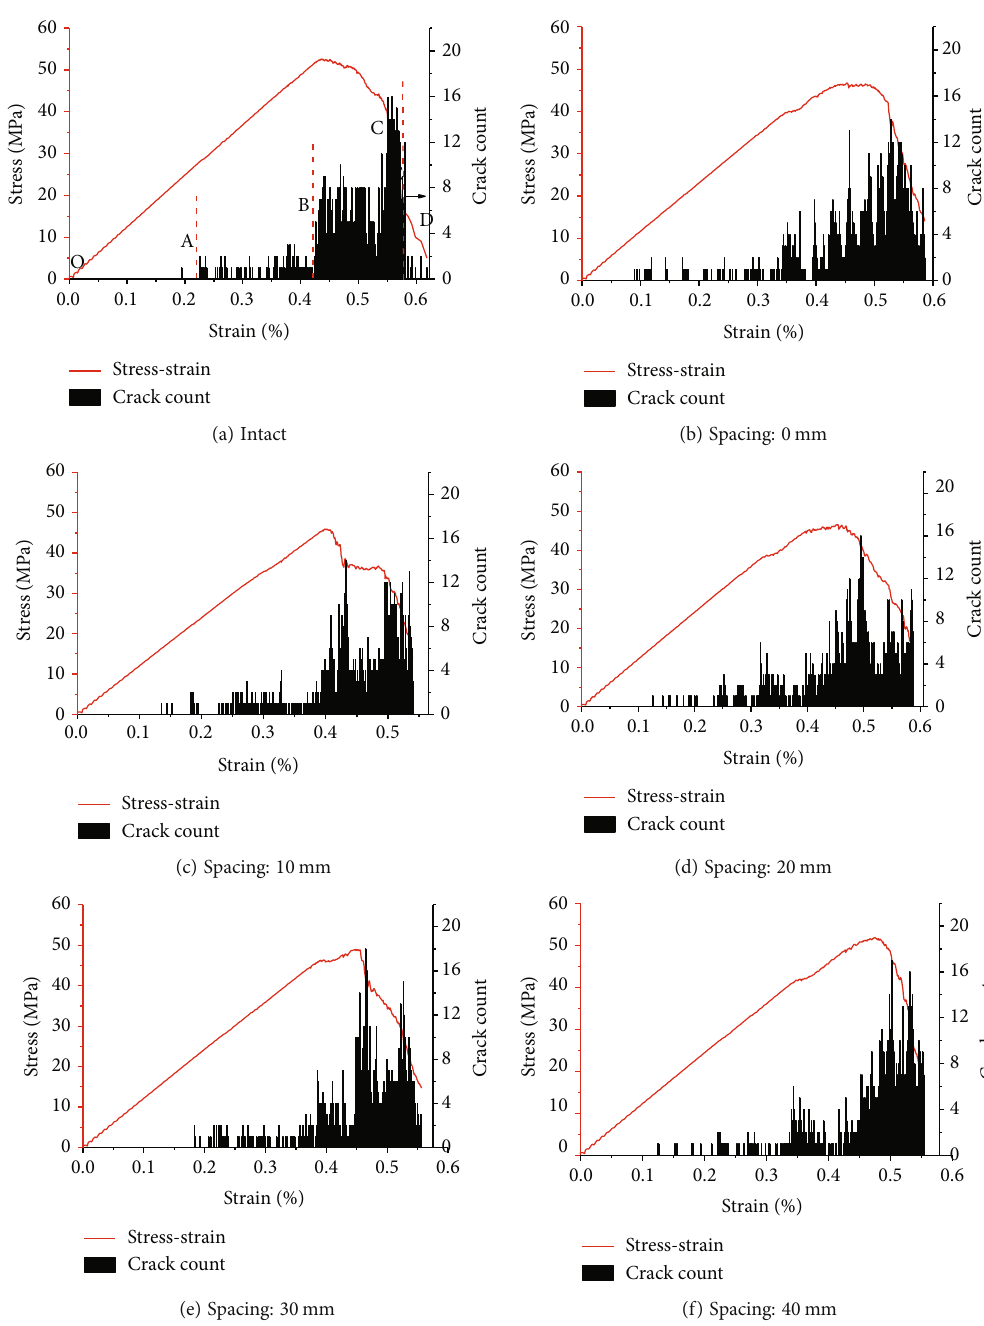
Figure 9: Stress-crack counts of models with di ff erent spacing between joints and